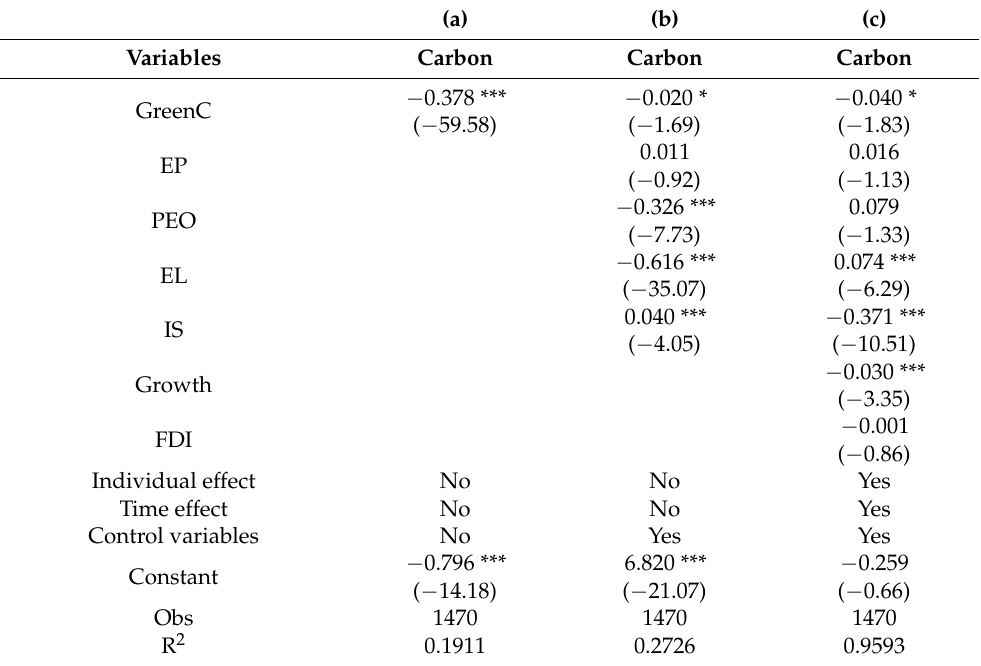
Table 6. Benchmark regression